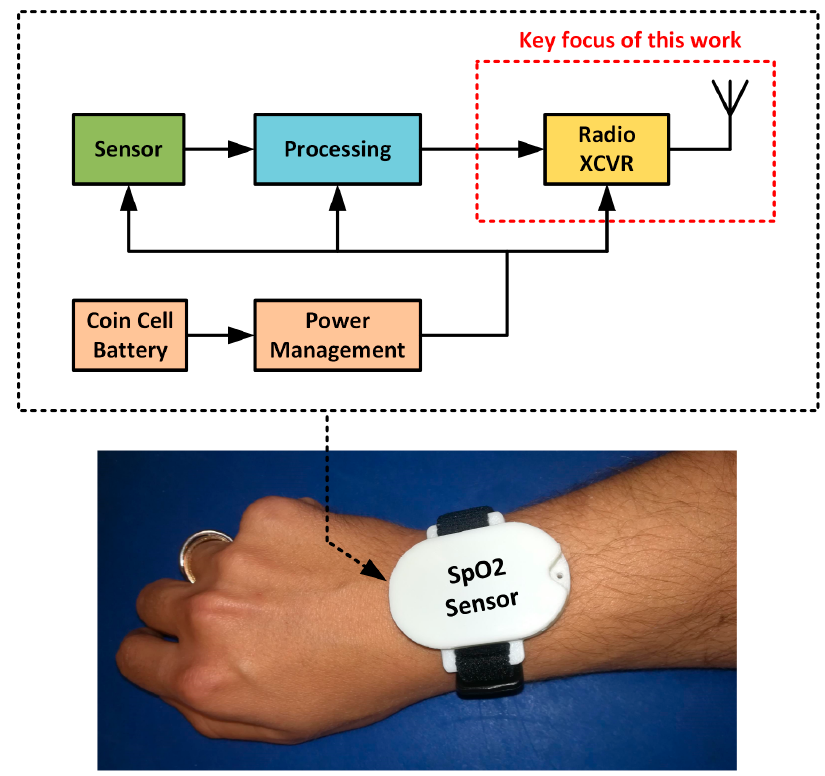
Figure 1. Wrist-worn wireless SpO2 sensor in final configuration with corresponding system block diagram.